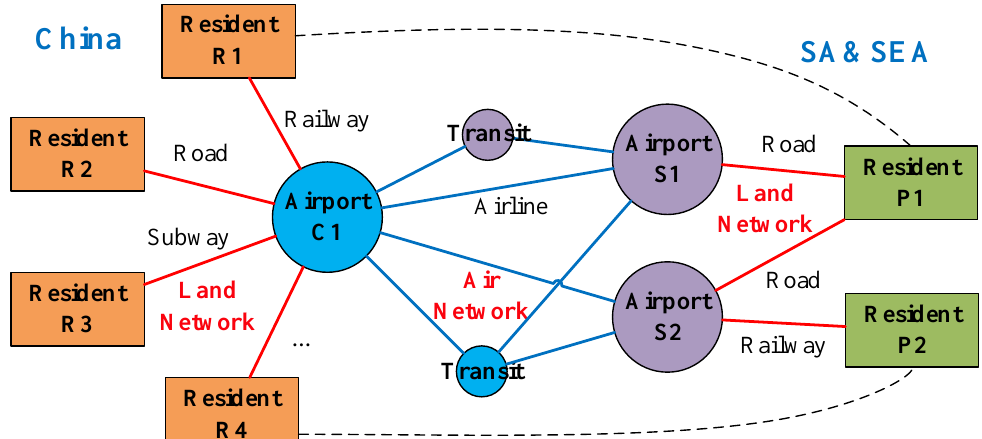
Figure 1. The explanation of the transnational travel from China residential areas to South Asia and Southeast Asia (SA&SEA) residential areas, including air and land transport networks.